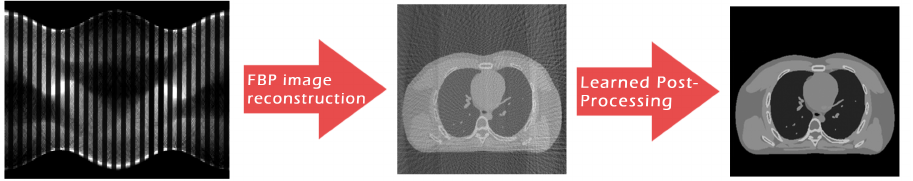
Figure 2. Graphical draft of the considered two-step workflow for tomographic reconstruction from sparse-view